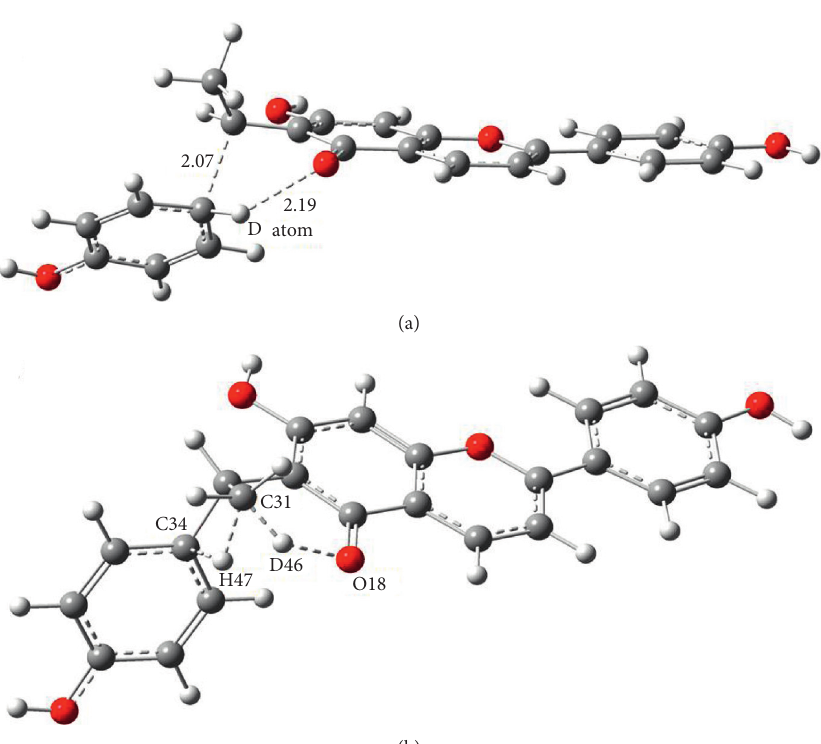
Figure 2: The transitional geometrical configurations of compound 7 by DFTcalculations (˚A). (a) The structure of TS1; (b) the structure of